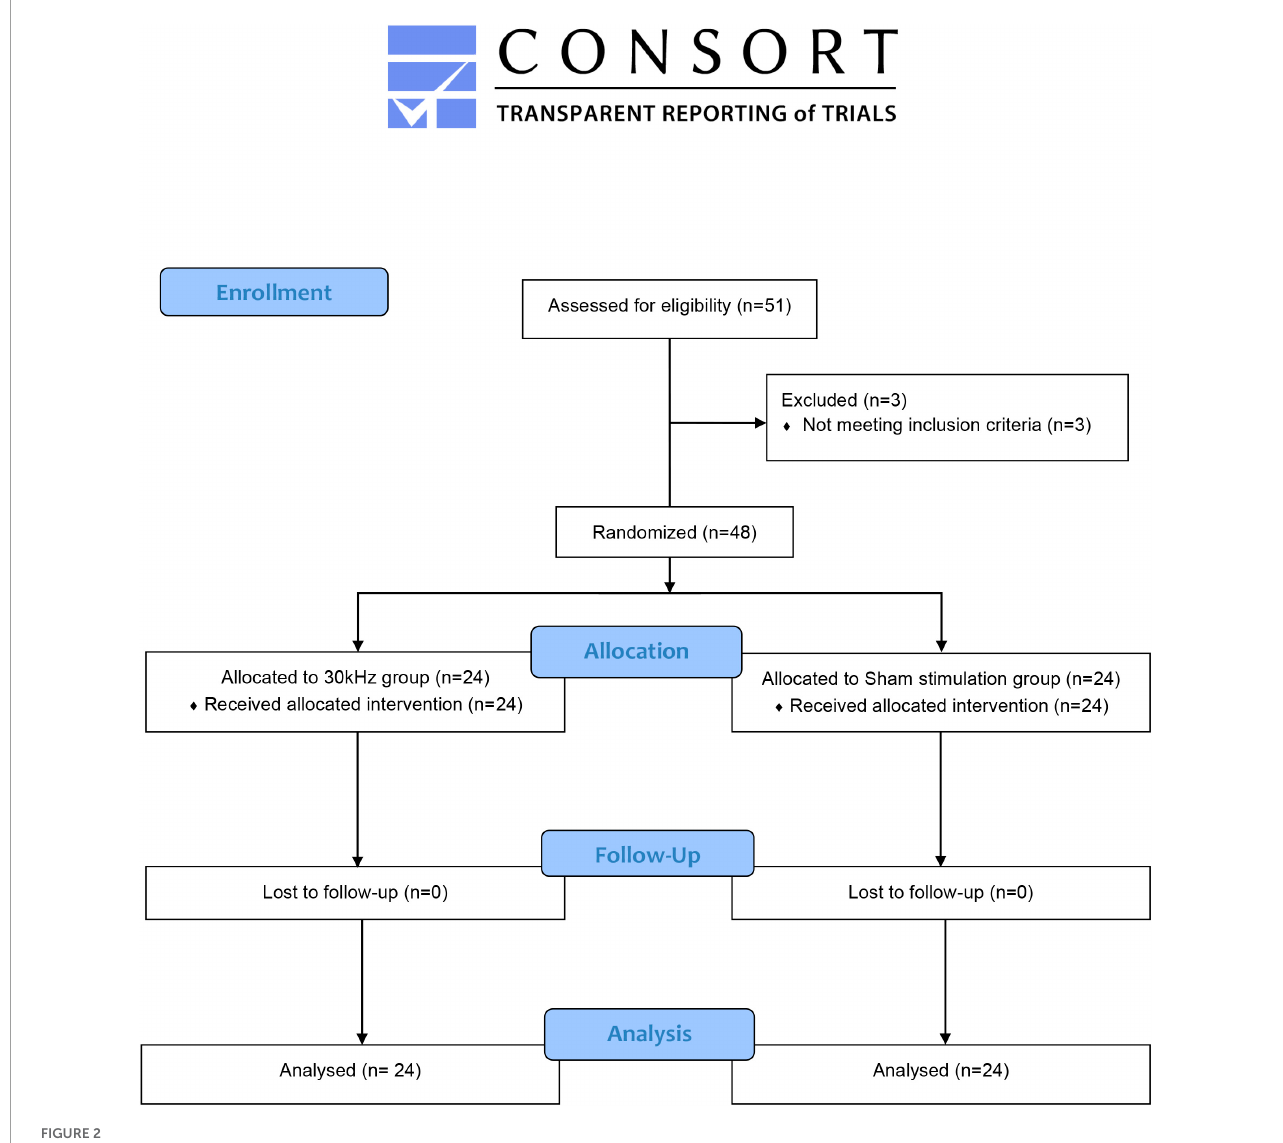
FIGURE2 Consort flow